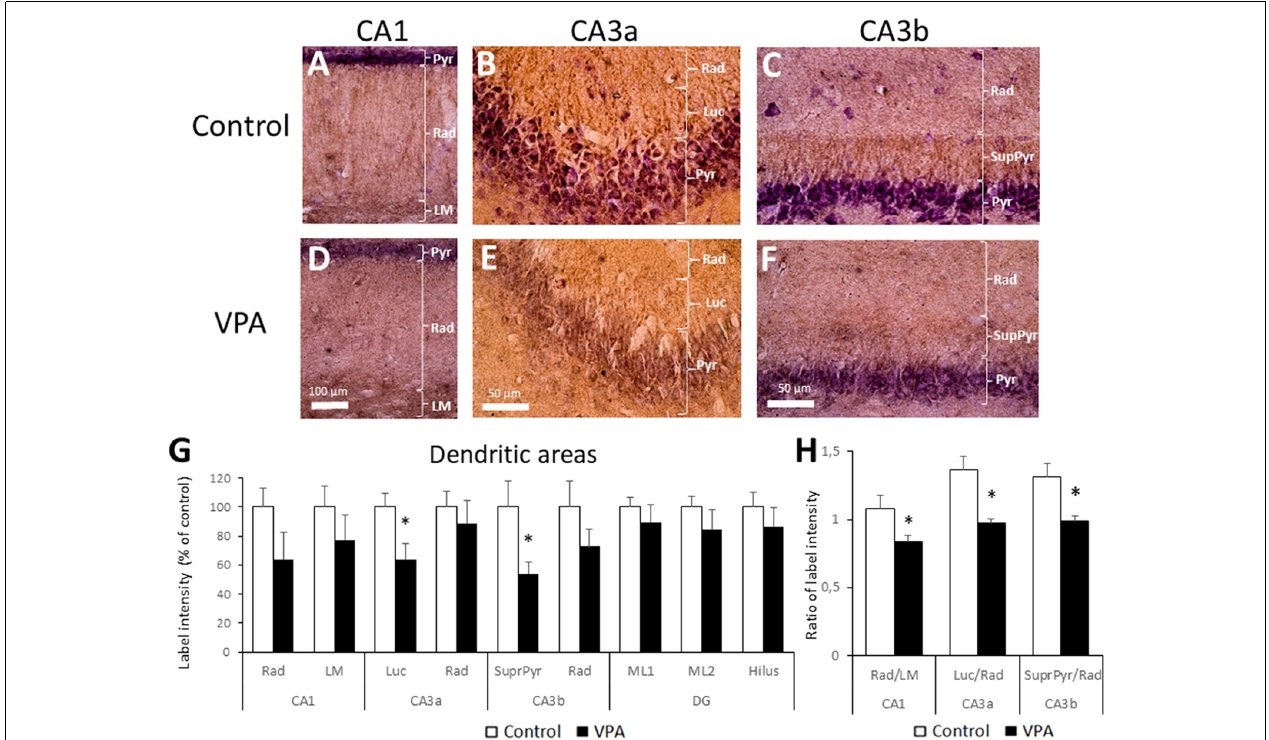
FIGURE 5 | Prenatal VPA treatment decreases BDNF inmunoreactivity in the CA3 lucidum and suprapyramidal layers. Representative microphotographs of CA1 (A,D) , CA3a (B,E) and CA3b (D,F) of control (A–C) and VPA-treated (D–F) rats. LM: stratum lacunosum moleculare , Rad: Stratum radiatum , Luc: Stratum lucidum and SupraPyr: suprapyramidal layer. The bar represents 500 µ m. (G) Bar graph representing the label intensity in dendritic areas of the hippocampus and DG. (H) Ratio of label intensity between proximal vs. distal portion of dendritic regions in CA1, CA3a and CA3b. The data represent the mean ± SEM. Controls are represented by white bars and VPA treated animals are represented by black bars. ∗ p < 0.05, t -test, except for SupraPyr/Rad ratio, where U -test was used. n = 7 for control and VPA-treated rats in all cases.